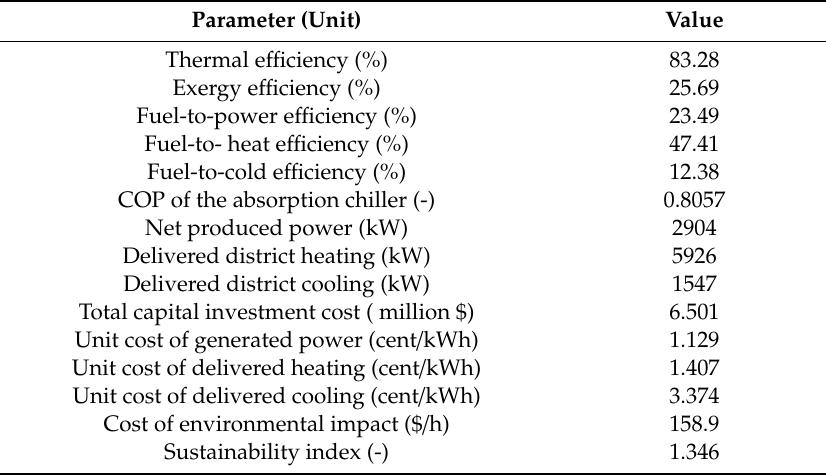
Table 4. Technical features obtained from simulation of the proposed municipal waste-driven CCHP system under the base